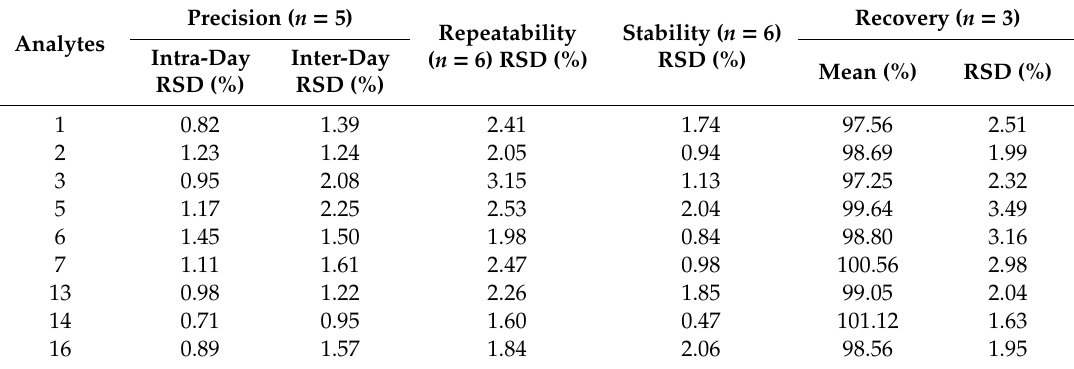
Table 6. Precision, repeatability, stability, and recovery of the